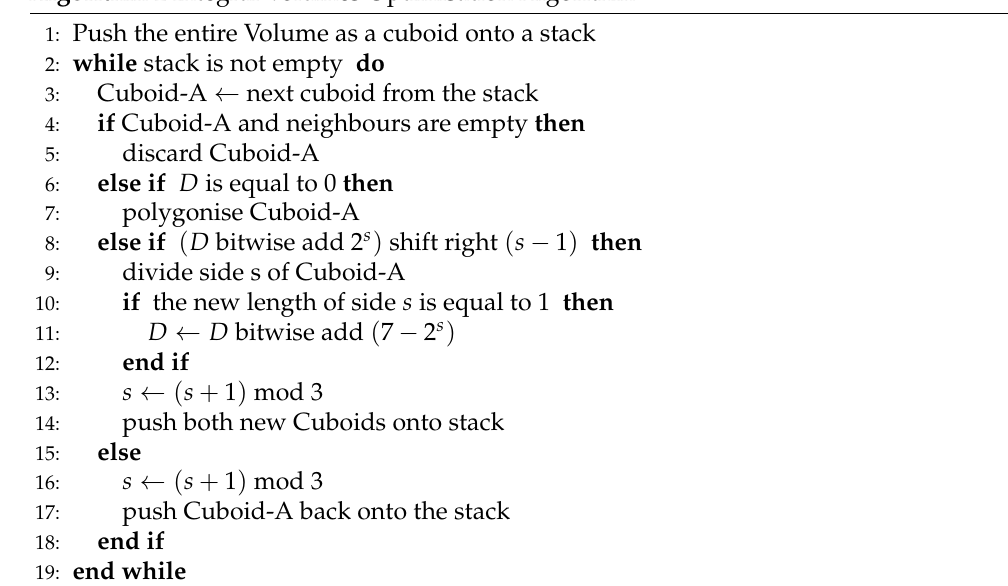
Algorithm 2 Integral Volumes Optimisation